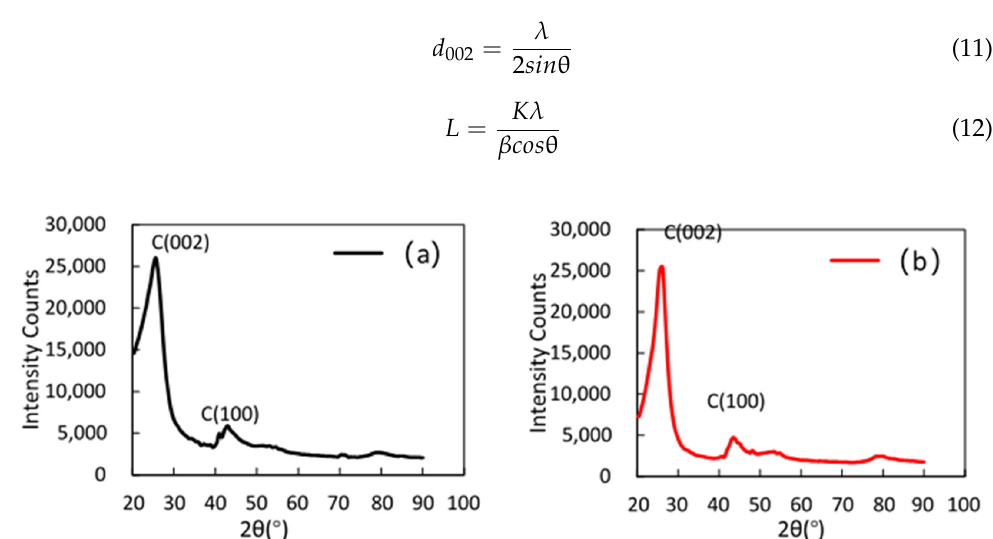
Figure 8. Results of crystal structure analysis by XRD: ( a ) unprocessed; ( b ) processed.